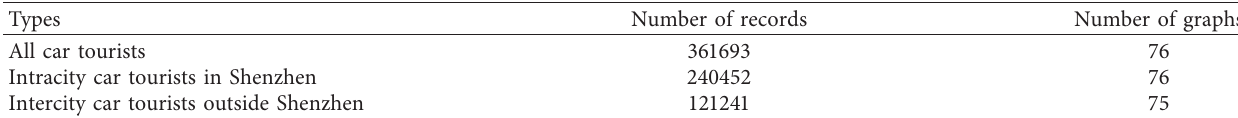
Figure 7: Flow map of tourism traffic. Table 2: Types of car tourist visiting the